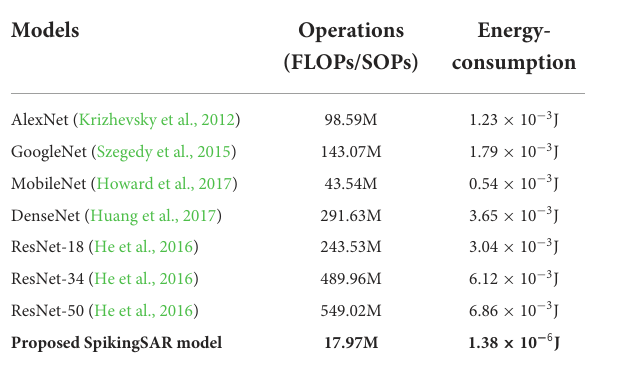
TABLE 3 Comparison of the operations (FLOPs/SOPs) and energy consumption for different models.